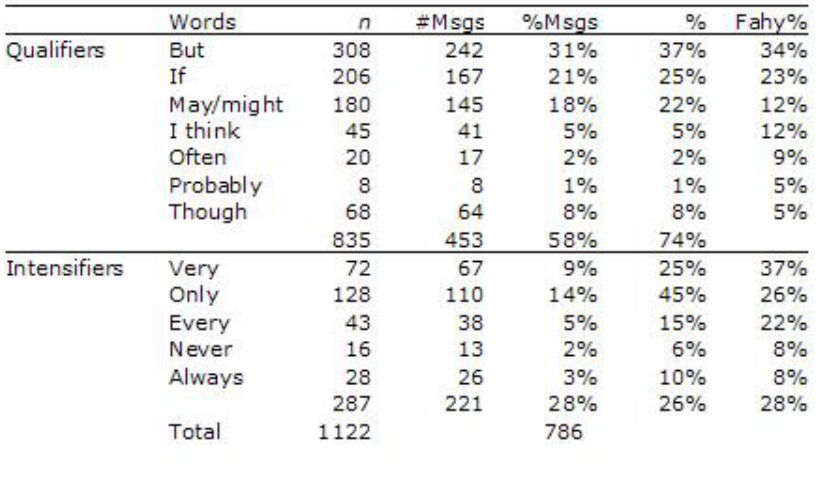
Note: Females used 43 percent more qualifiers per message ( M = 1.21, STD = 1.49, n = 470) than